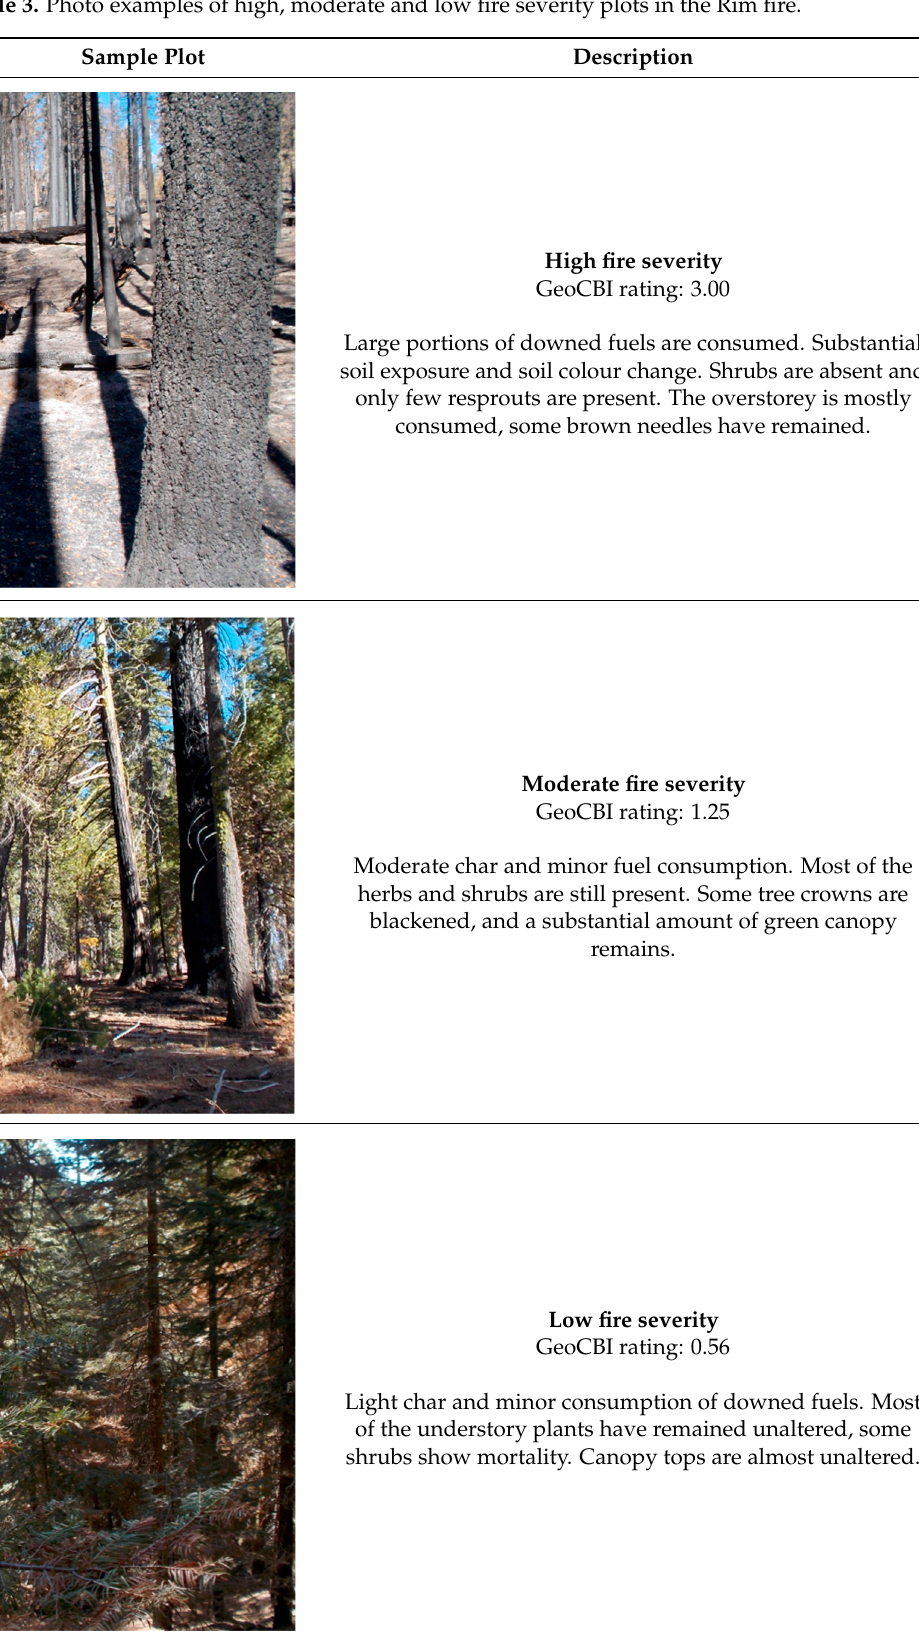
Table 3. Photo examples of high, moderate and low fire severity plots in the Rim fire.